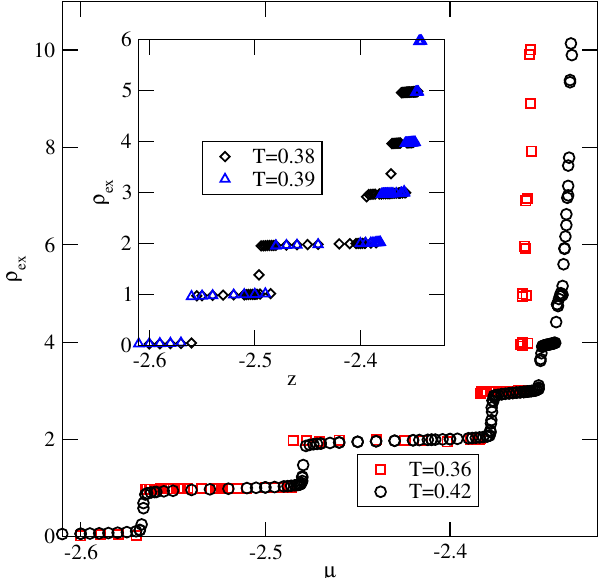
Figure 18. The adsorption isotherms for the system with u AB = − 1.0 and V o = − 1.00. The main part shows the isotherms at the temperatures, at which complete wetting occurs, while the isotherms presented in the inset correspond to the temperature region over which only a partial wetting appears.